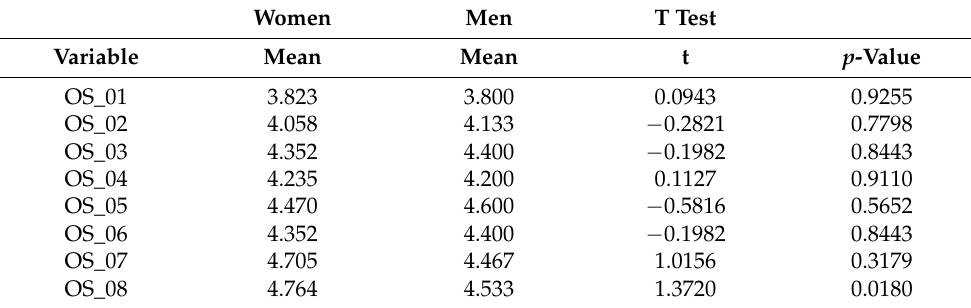
Table 10. Overall satisfaction by